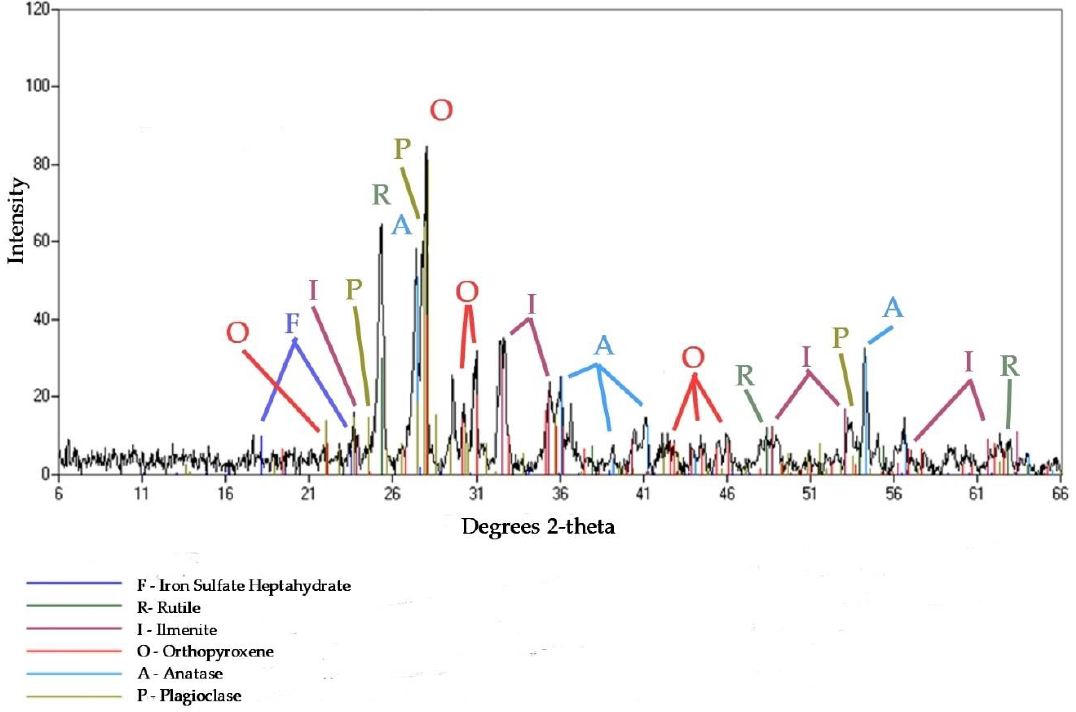
Figure 2. XRD pattern of R-MUD sample.